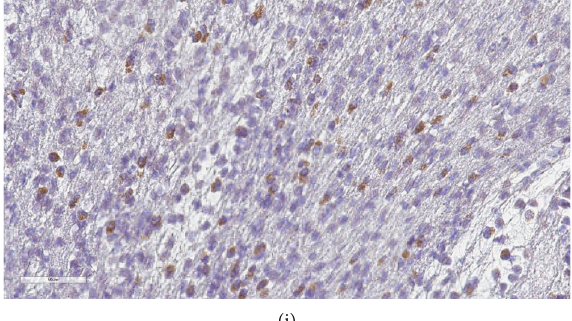
Figure 4: Immunohistochemistry staining in thrombi. Histology and immunohistochemistry (brown signal) of thrombus. Initial magni fi cation × 40, but pictures downsized afterwards. Scale bars indicate 50 micrometers. Histologic age 1 + 2 (Supplementary Table 1). The panels show the following stainings: HE (a), visualizing fi brin organization and varying in fi ltration of granulocytes and monocytes. TLR4 (b), present in cytoplasm and cell membrane of monocytes and granulocytes. NLRP3 (c), present in cytoplasm of monocytes. Caspase-1 (d), present in nucleus and cytoplasm of monocytes and granulocytes. IL-1ß (e), present in cytoplasm of monocytes and some granulocytes. IL-18 (f), present in cytoplasm of monocytes and granulocytes. IL-6 (g), present in cytoplasm of monocytes. IL-6R (h), present in cytoplasm of monocytes. Gp130 (i), present in nuclear membrane and cytoplasm of monocytes and granulocytes. Abbreviations: HE: hematoxylin and eosin; TLR4: Toll-like receptor 4; NLRP3: Nod-like receptor protein 3; IL-1 β : Interleukin 1 β ; IL-18: Interleukin 18; IL-6: Interleukin 6; IL-6R: Interleukin 6 receptor; Gp130=Glycoprotein